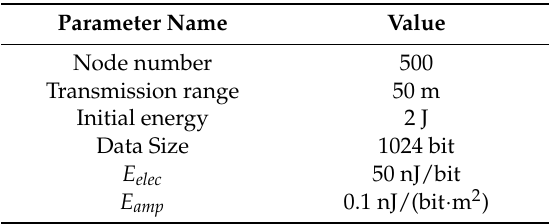
Table 2. Experimental parameters.